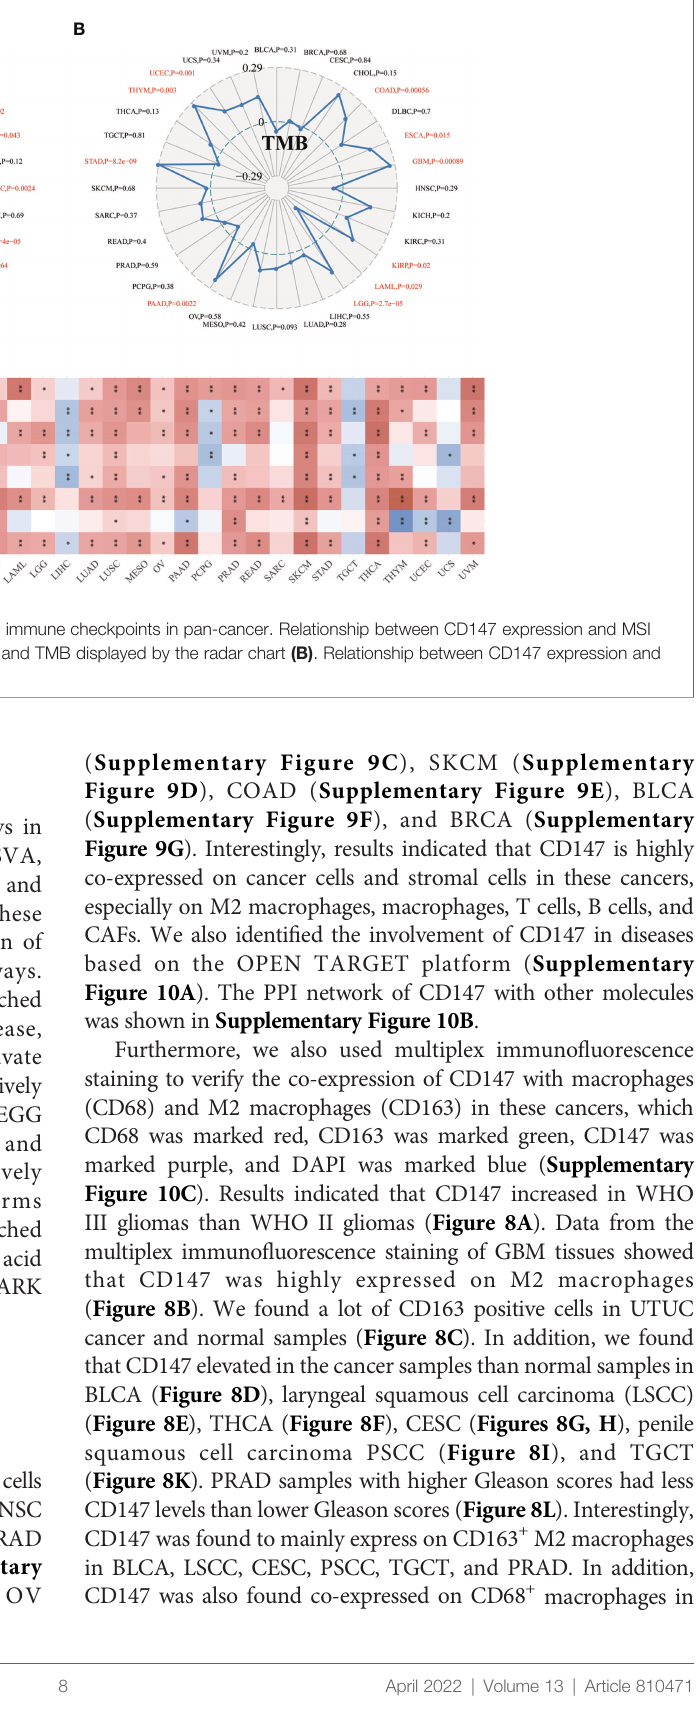
FIGURE 5 | Relationship between CD147 expression and MSI, TMB, and immune checkpoints in pan-cancer. Relationship between CD147 expression and MSI displayed by the radar chart (A) . Relationship between CD147 expression and TMB displayed by the radar chart (B) . Relationship between CD147 expression and immune checkpoints (C) . *p< 0.05, **p <